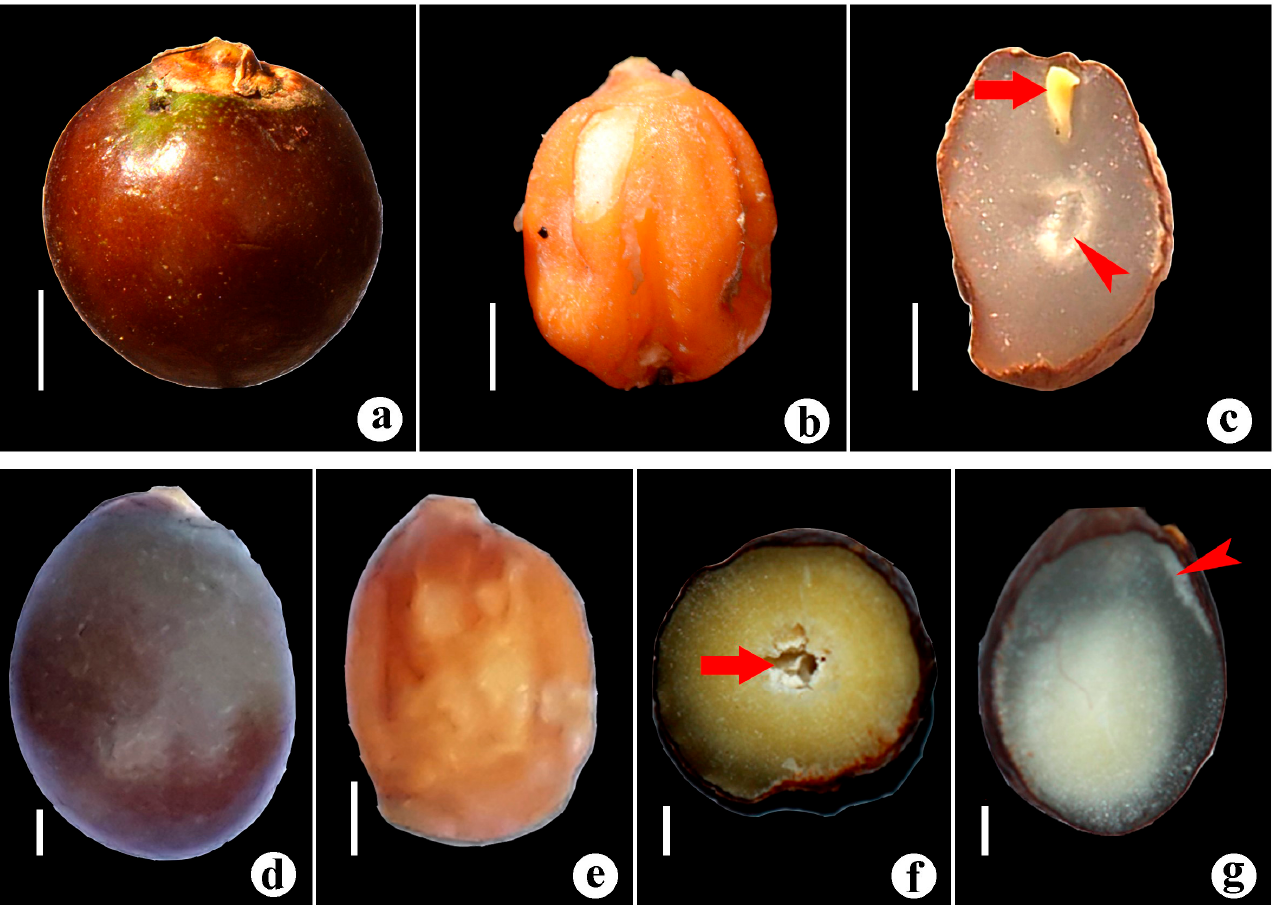
Figure 8. Fruits and seeds in Bentinckia species. B. condapanna ( a ) fruit, ( b ) seed, and ( c ) cross section of seed. Arrow shows apical embryo and arrowhead horny albumen. Scale bars = 0.2 cm. B. nicobarica ( d ) fruit ( e ) seeds, and ( f , g ) cross section of seed. Arrow shows ribbed albumen and arrowhead apical embryo. Scale bars = 0.2 cm.